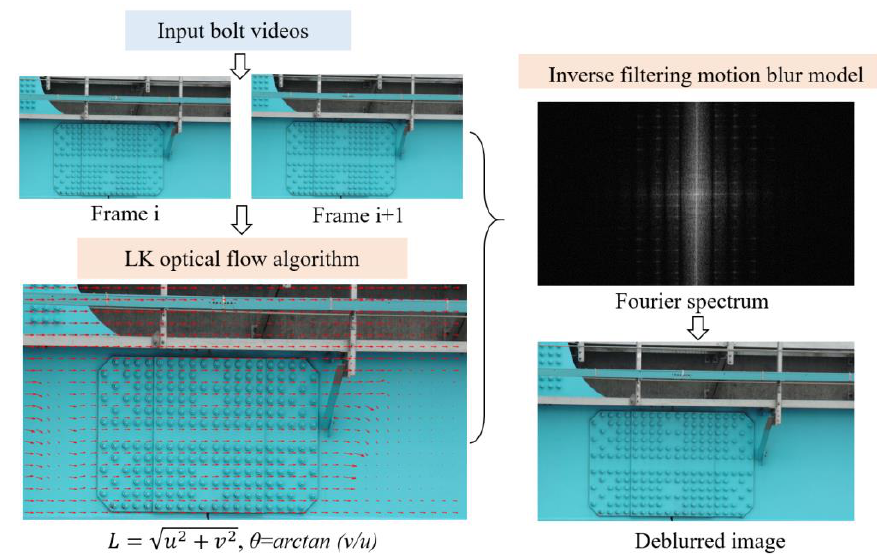
Figure 4. Motion deblurring using optical flow and inverse filtering.